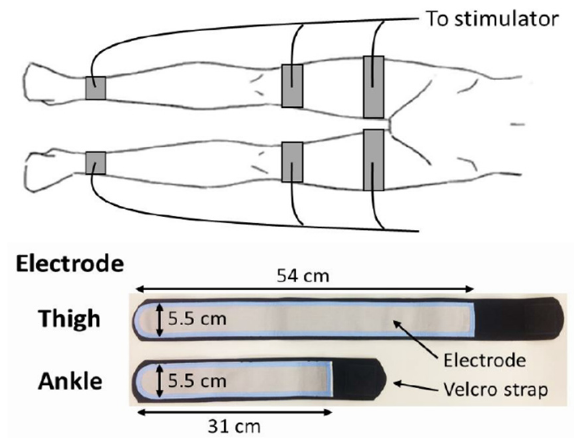
Figure 1. Belt electrode skeletal muscle electrical stimulation.